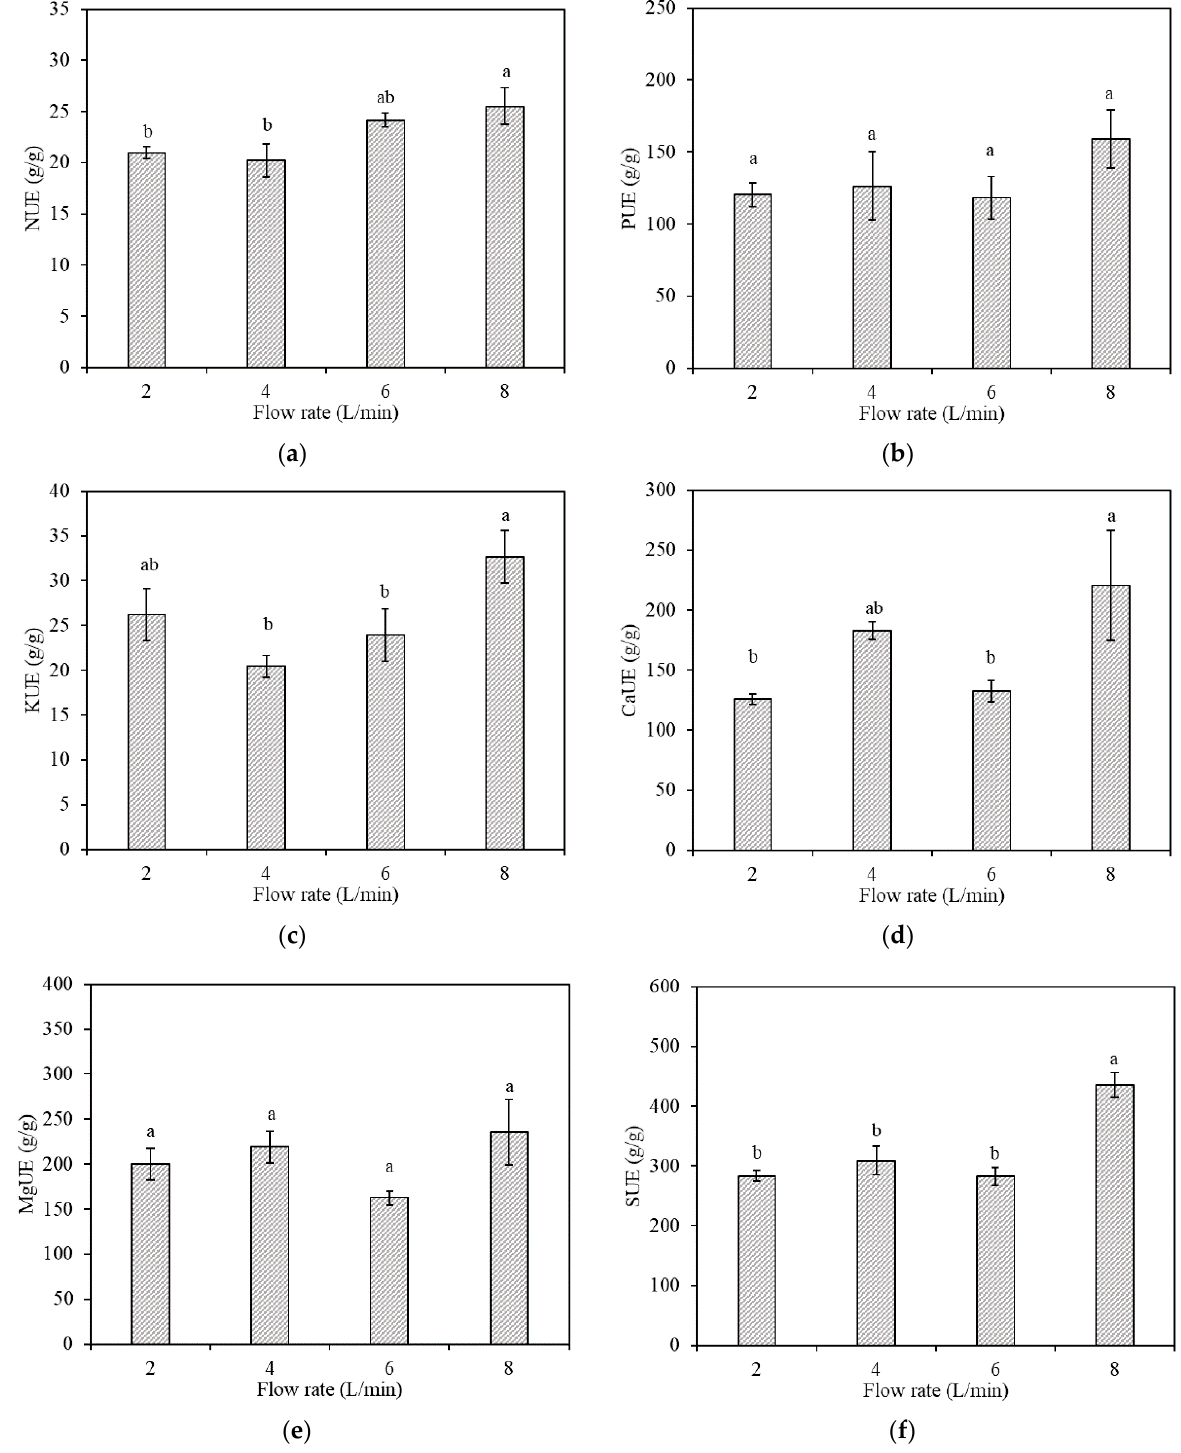
Figure 4. Nutrient use efficiency under different flow rates (values are calculated by dry weight/nutrient uptake of a whole plant). ( a ) Nitrogen use efficiency (NUE); ( b ) phosphorus use efficiency (PUE); ( c ) potassium use efficiency (KUE); ( d ) calcium use efficiency (CaUE); ( e ) magnesium use efficiency (MgUE); ( f ) sulfur use efficiency (SUE). There were significant differences in the bars marked with different letters ( p < 0.05). Data are expressed as means ± standard error ( n = 4).